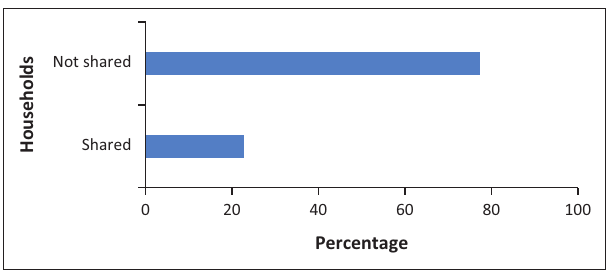
FIGURE 2: Households with access to flush shared versus non-shared toilets.